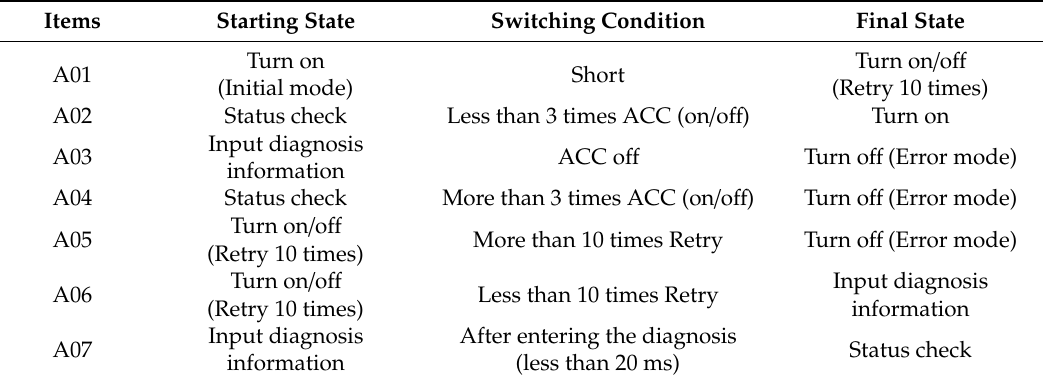
Figure 9. State switching diagram. Table 3. Operating state and switching conditions used in the diagnostics routines to improve the operational